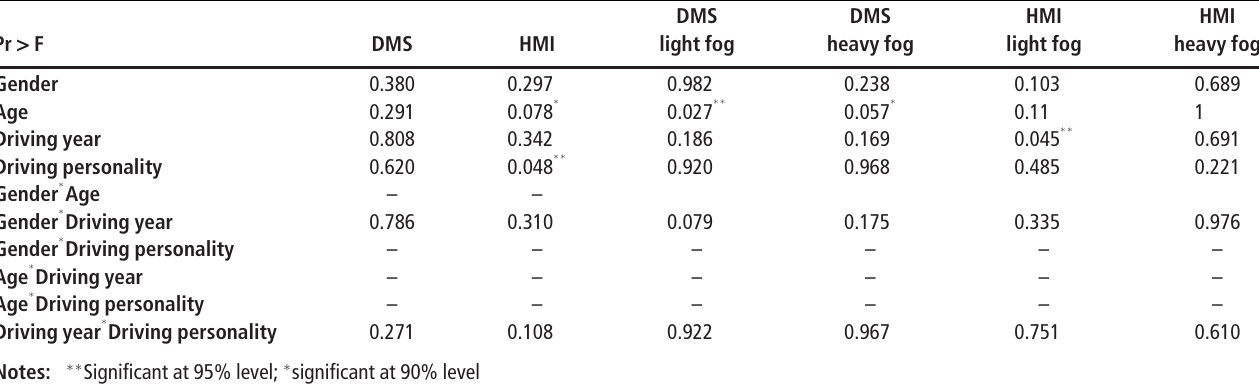
Table IV Analysis results of the effect of driver ’ s gender, age, driving experience, and driving personality on CV-VSL acceptance Pr >